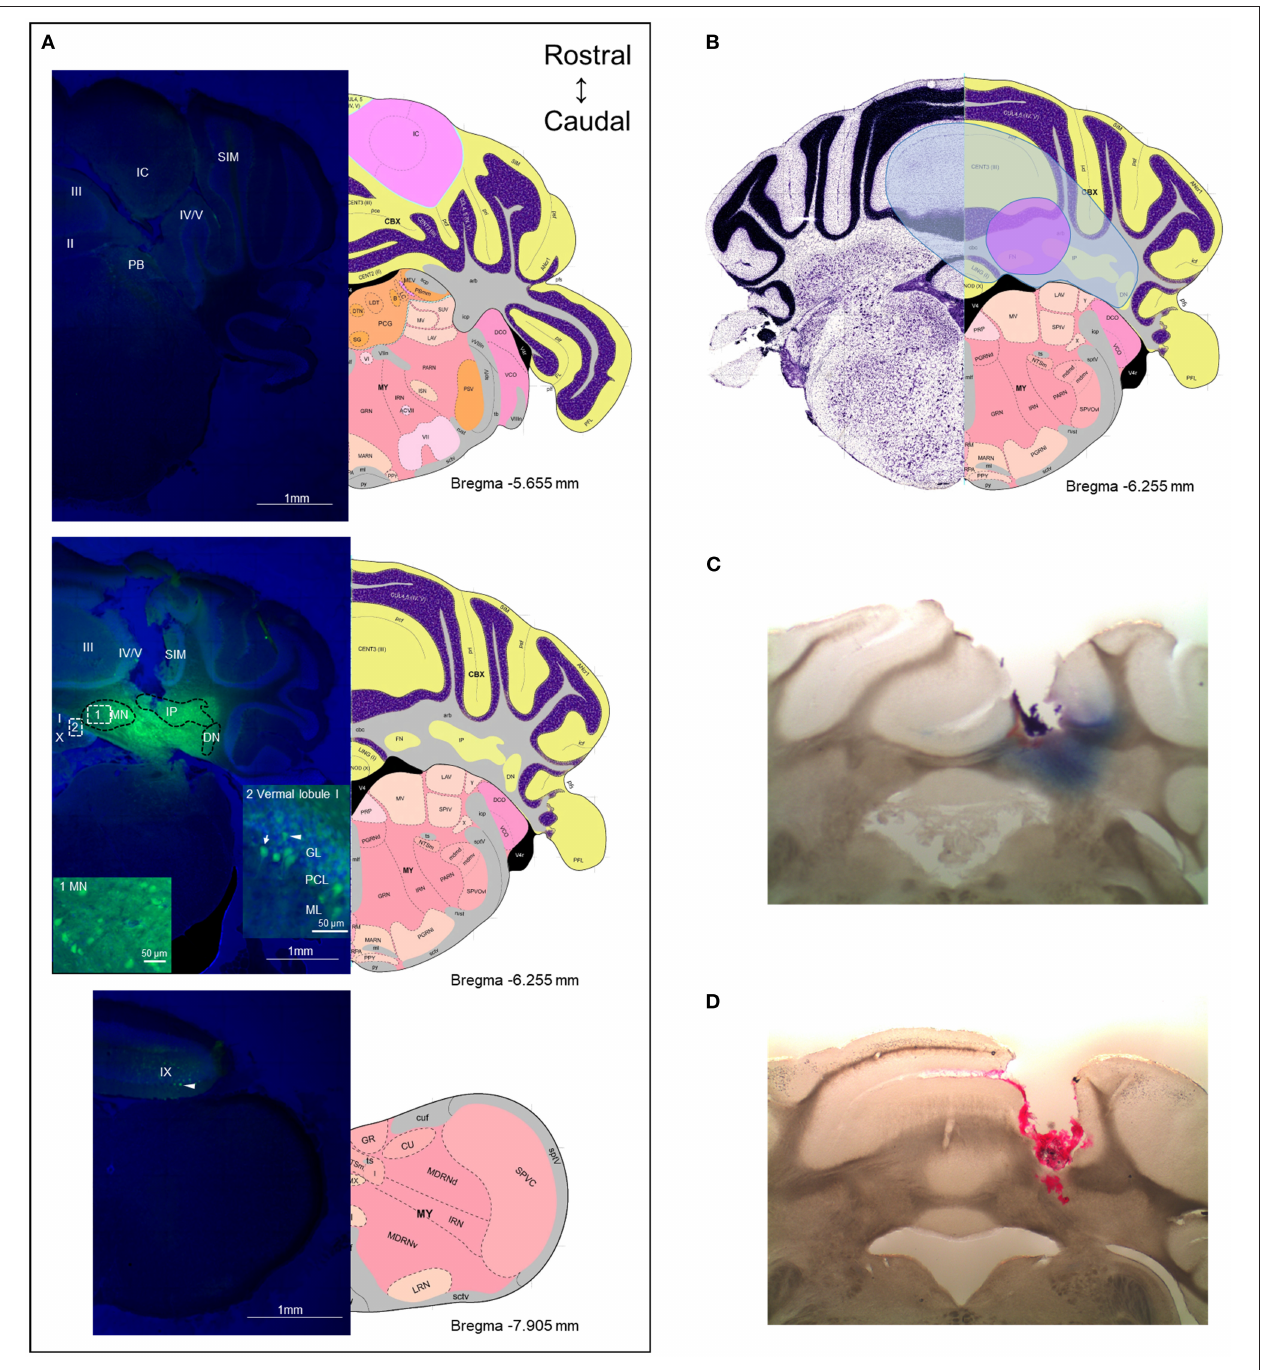
FIGURE 7 | The diffusion range of CGRP. (A) Representative example of a mouse after injection of fluorescein-15-CGRP. Upper panel: In the most rostral section, dim fluorescence was detected in the inferior colliculus, the parabrachial nucleus, vermal lobules II-V, and the simple lobule. Middle panel: Fluorescein-15-CGRP at the injection site. Areas within rectangle are magnified in boxes 1 and 2. Clusters of fluorescein-15-CGRP were detected in cell bodies in the MN (box 1) and nearby cells, including the interposed and lateral cerebellar nuclei, granular, Purkinje cell, and molecular layers of vermal lobules I/III/IV/V (box 2). Dim signal was found in the simple lobule of the hemispheric regions. Lower panel: In the most caudal section, dim fluorescence was detected in lobule IX. Green: fluorescein-15-CGRP; Blue: TO-PRO-3. (B) The spread of the green fluorescence among the mice injected with fluorescein-15-CGRP. The smallest (purple shading) spread of signals covers the MN and few of nearby cells in the vermal lobules III/IV/V. The largest spread (blue shading) covers the MN and cells beyond the MN including vermal lobules I/III/IV/V/X, the simple lobule and other cerebellar deep nuclei. In summary, florescent signals were found in vermal lobules I-X, the simple lobule in the hemispheric region, and